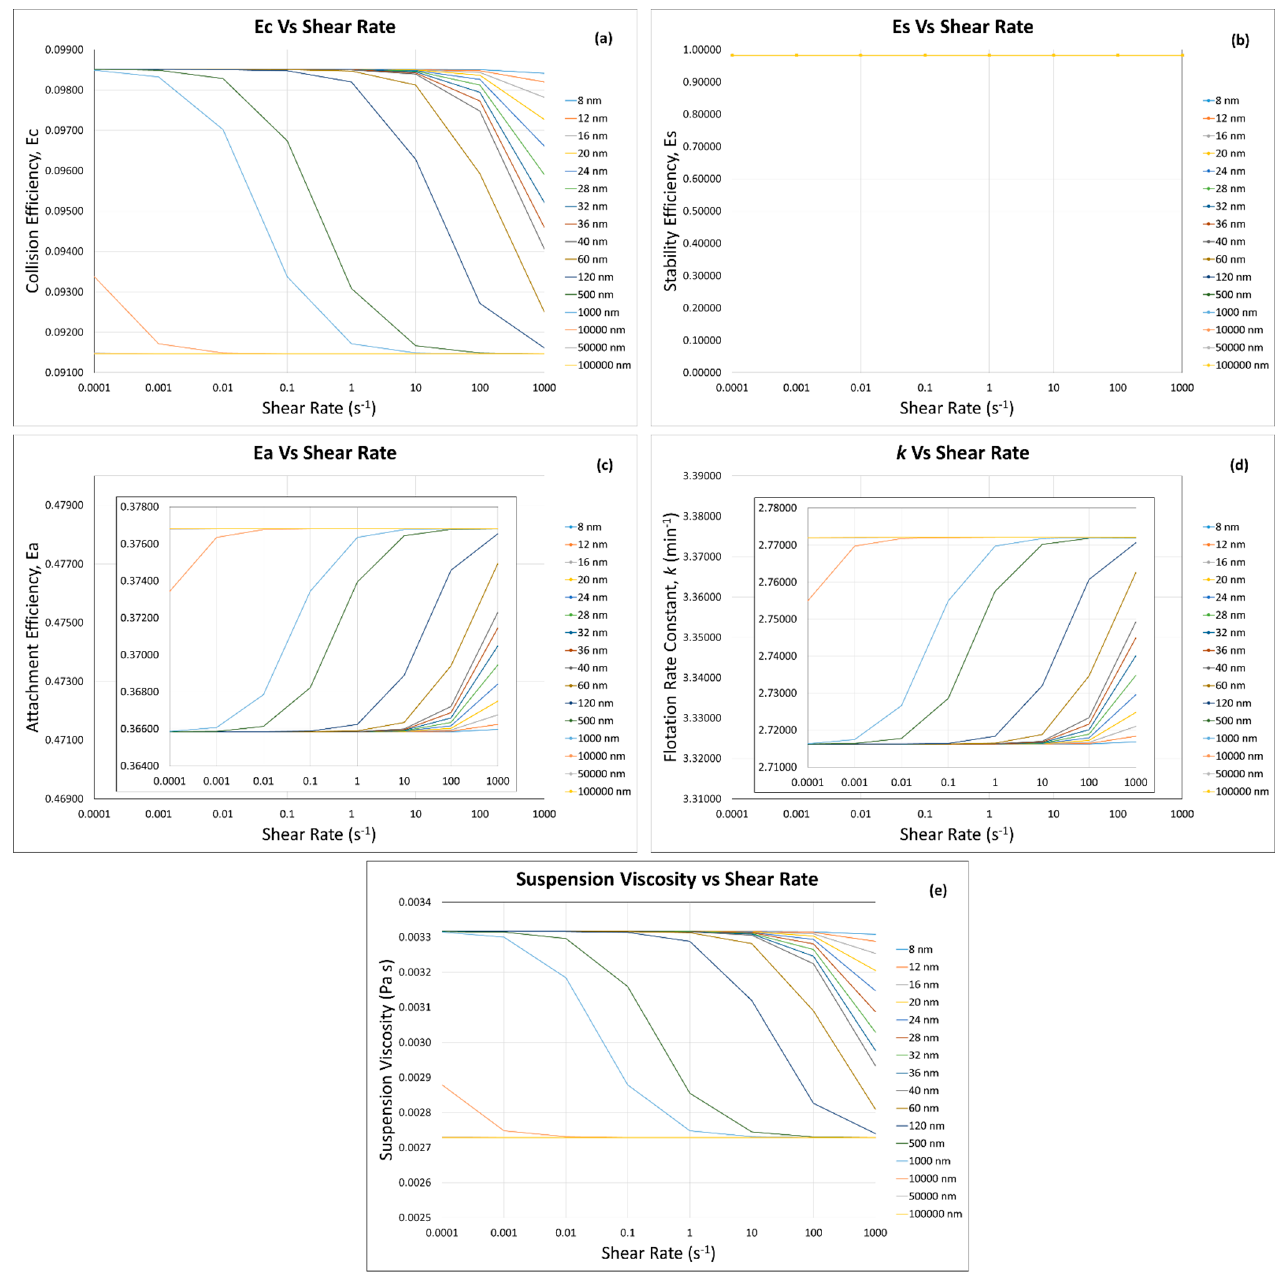
Figure 10. Flotation efficiencies: ( a ) collision, ( b ) stability, ( c ) attachment, and ( d ) rate constant by using ( e ) the suspension viscosity calculated by the predictive model (same quartz particles with same sizes) at 𝜙 = 0.3 . Note: the major y-axes of subfigures ( c , d ) are made for the purpose of comparison.